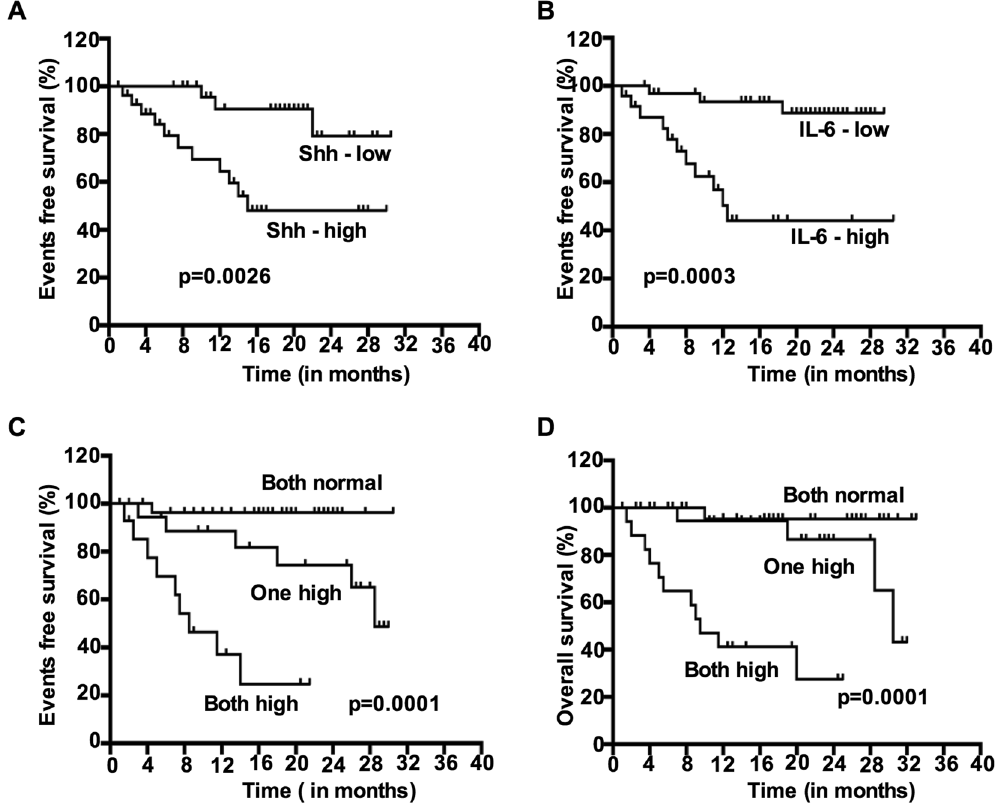
Figure 6. Risk stratification based on EFS and OS correlates with serum Shh and IL-6 levels in metastatic breast cancer. ( A ) Event free survival (EFS) of all progressive metastatic patients by serum Shh levels, ( B ) EFS of all progressive metastatic patients based on serum IL-6 levels, ( C ) EFS of all progressive metastatic patients based on a two-factor model (serum Shh and IL-6). ( D ) Overall survival (OS) of all progressive metastatic patients based on a two-factor model (serum Shh and IL-6). Note worse overall outcome for patients with both Shh and IL-6 at a high